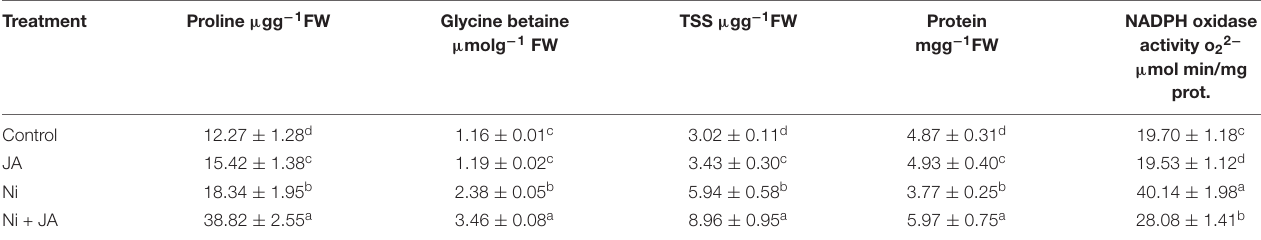
TABLE 3 | Effect of Ni (2 mM) and JA individually and in combination on proline, glycine betaine, Total soluble sugar, protein content, and NADPH oxidase activity in soybean seedlings.